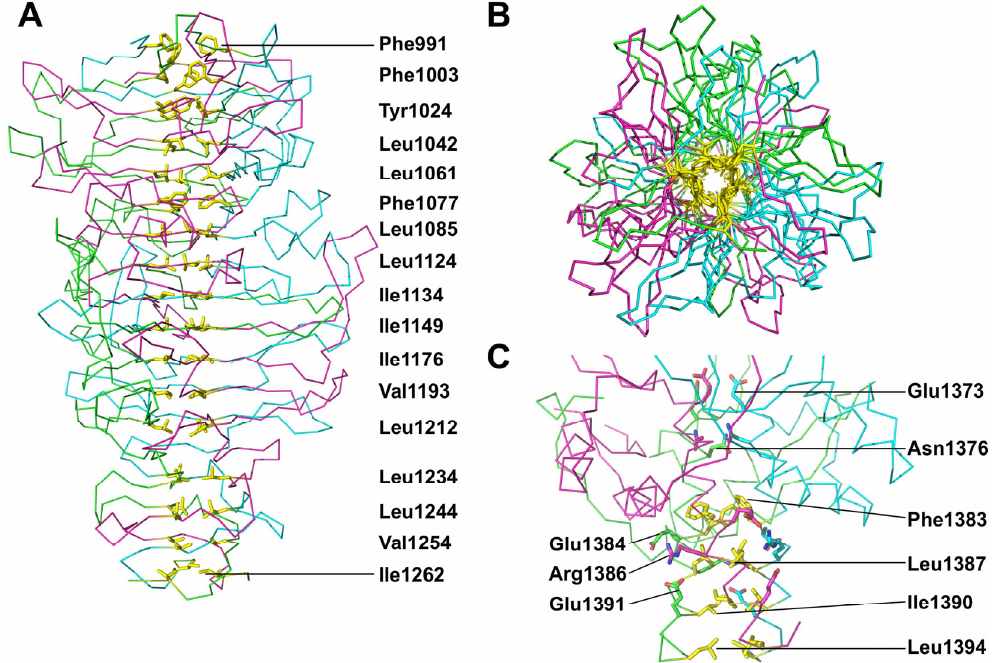
Figure 5. Inter-monomer interactions in the bacteriophage T5 L-shaped fibre trimer. ( A ) Side view of the C-terminal fibre domain, with the residues contributing to the central hydrophobic core shown in yellow and labelled on the right; ( B ) Top view of A, illustrating how the aromatic and hydrophobic residues contribute to the core; ( C ) Central interactions in the chaperone domain. Hydrophobic side-chains are shown in yellow and other residues in the same colour as the protein chain they belong to.